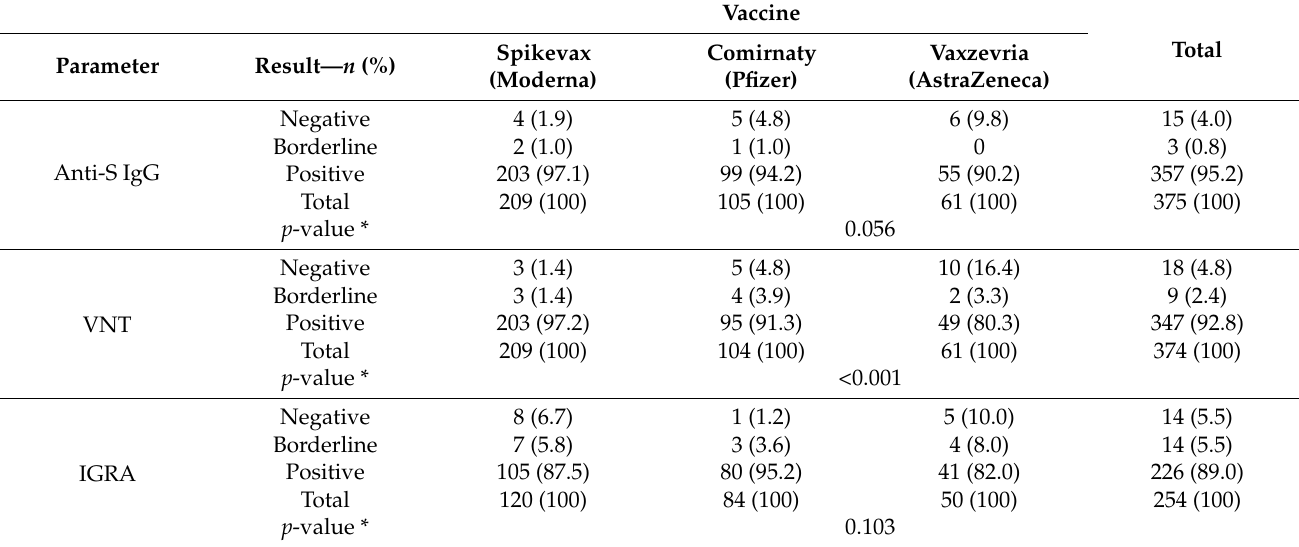
Table 2. Results of anti-S IgG, virus neutralization test, and results of interferon-gamma release assay indicating T-cell immunity for individual